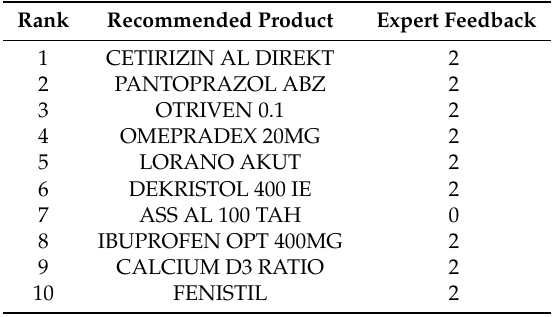
Table 1. Example recommendations for prednisolone, a